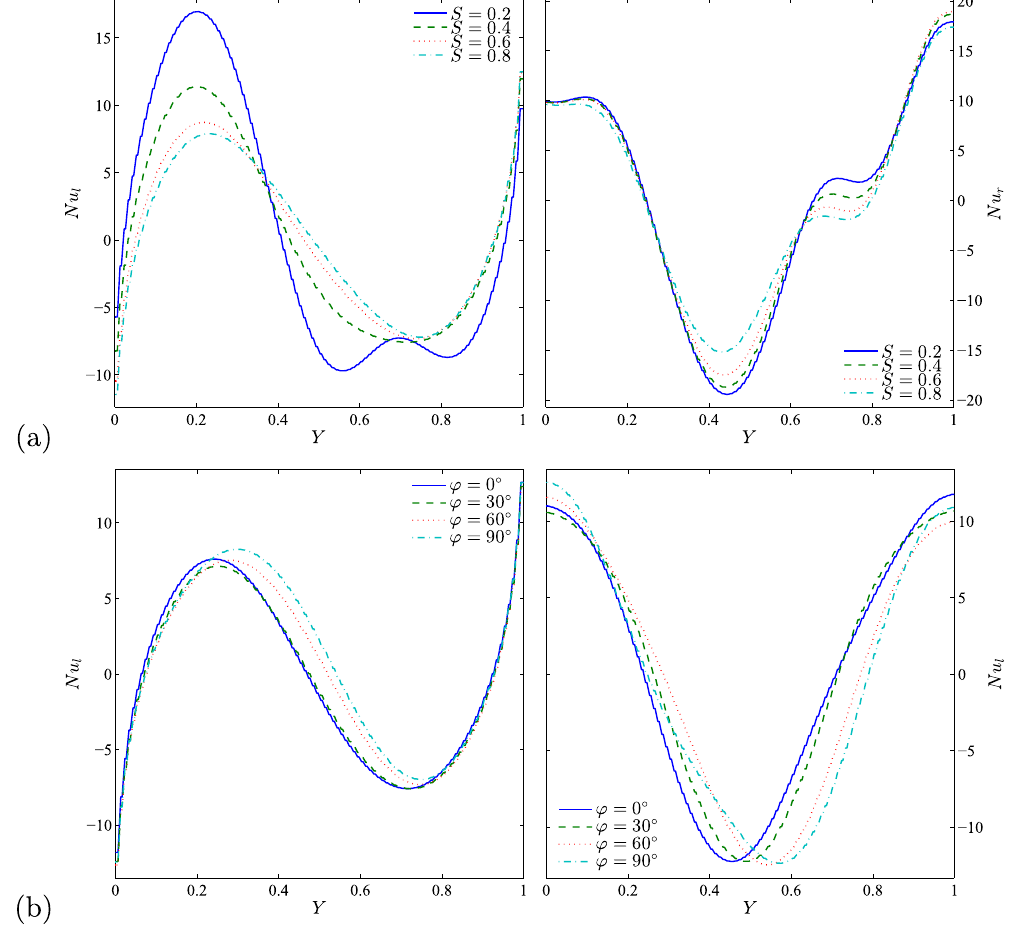
Figure 12. Values of Nu interfaces with Y for ( a ) different S and ( b ) different ϕ at Ra bf = 10 5 , Da = 10 − 4 , γ = π ε = 1 and φ =